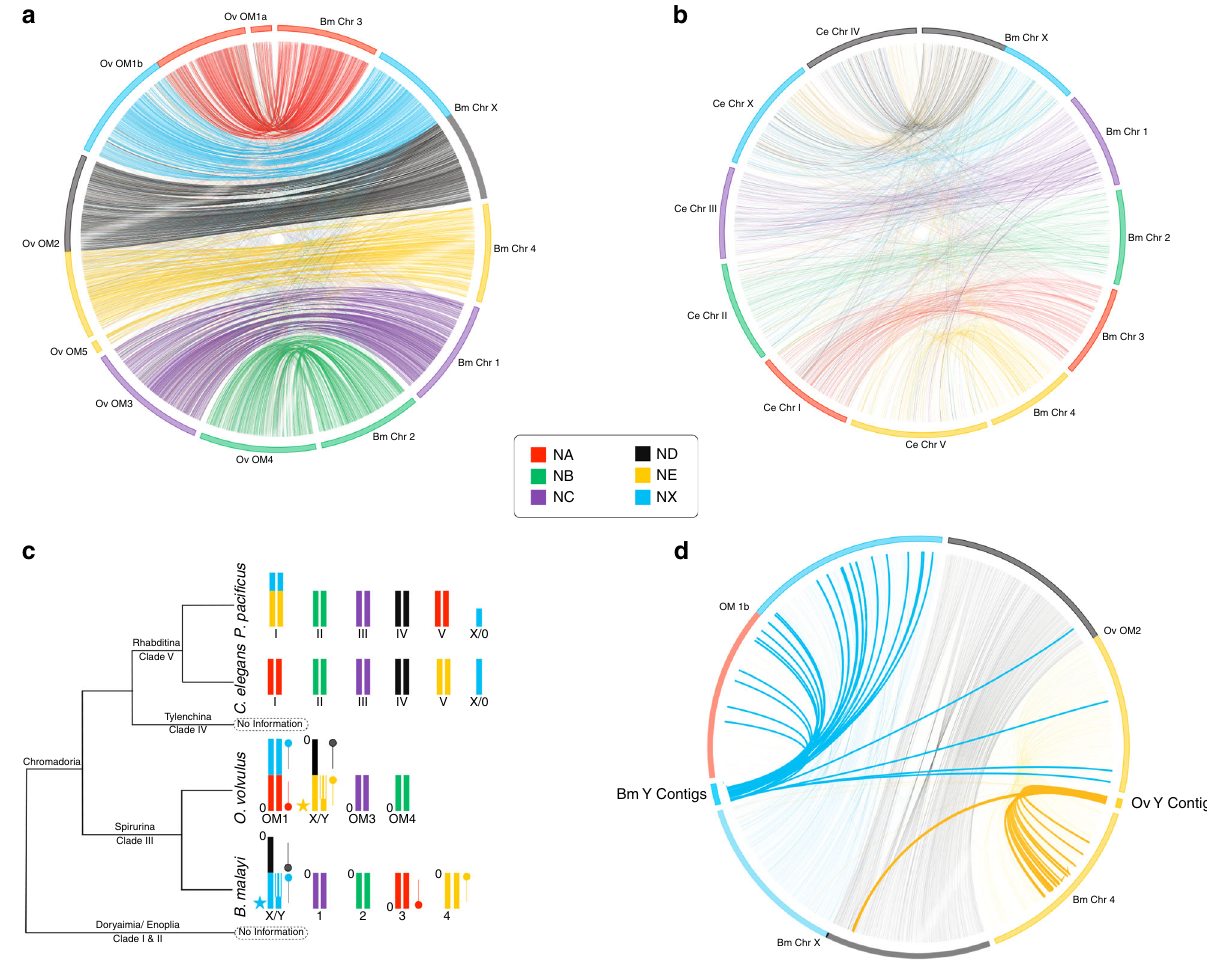
Fig. 1 Homology between B. malayi , O. volvulus , and C. elegans chromosomes using conserved blocks. The B. malayi chromosomes were mapped against the a O. volvulus and b C. elegans chromosomes. The correlation between chromosomes was predicted using comparisons of chromosome homology between B. malayi, O. volvulus , and C. elegans . The nematode chromosomes were broken into Nigon elements, with the coloring based on corresponding regions in C. elegans chromosomes. c A model of chromosome evolution is provided according to clades 3,4 , where each Nigon element is color-coded and described by the number of the corresponding C. elegans chromosome. The stars denote the PAR in both O. volvulus and B. malayi , color-coded by element, and the pins appearing next to the chromosomes denote the orientation of the Nigon elements between these two species, with “ 0 ” representing where the contig in the fasta fi le begins relative to the diagram. The portion of the Y chromosome that is signi fi cantly diverged from the X chromosome yet maintains identity with the Nigon element is illustrated with stripes. The Y chromosomes between O. volvulus and B. malayi have arisen twice from two different autosomes, while the X chromosomes also show signi fi cantly different composition, which further correlates to the composition of the Y chromosome. Despite these differences, in both B . malayi and O. volvulus , ND is now part of the X chromosome and is 1N . d Putative B. malayi Y contigs are mapped to relevant O. volvulus chromosomes, and putative O. volvulus Y contigs are mapped to relevant B. malayi chromosomes. The conserved sequences between the B. malayi chromosome Y-speci fi c contigs and the O. volvulus NX span 150 kbp, while they span only 15 kbp for ND and 7 – 9 kbp for all the remaining Nigon elements. When combined with the PAR, this suggests that chromosome Y is largely derived from NX.